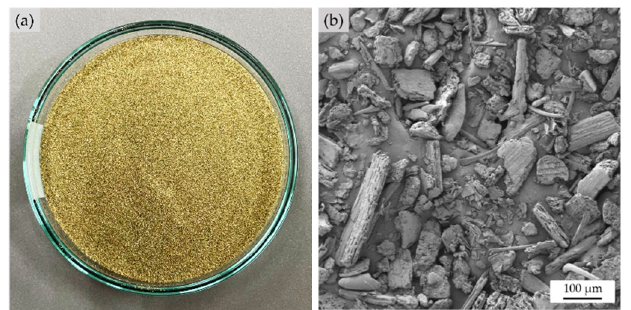
Figure 1. The appearance and shape of bamboo leaf fibers: ( a ) photograph; ( b ) SEM micrograph at a 100× magnification